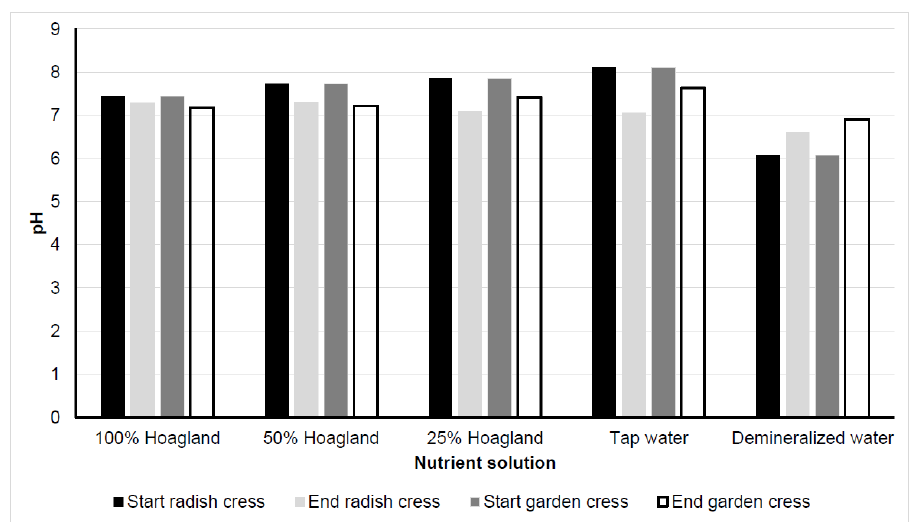
Figure 4. Average pH of the nutrient solution of two measurements at the beginning of cultivation and at harvest of the microgreens radish and garden cress.